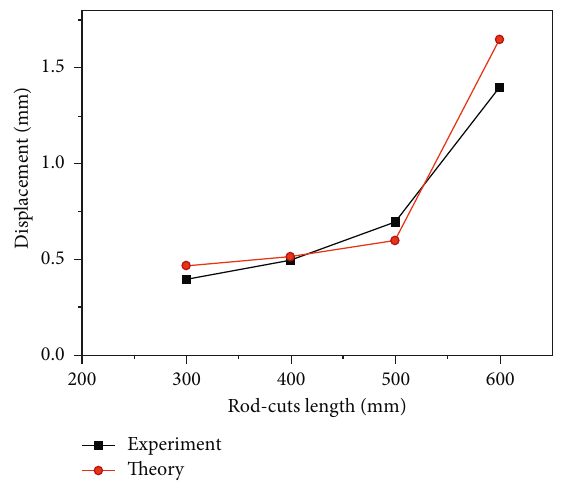
Figure 11: Comparison of experimental and theoretical displacements of the Zry-4 tube. Table 1: Advantages and disadvantages of different types of decladders.